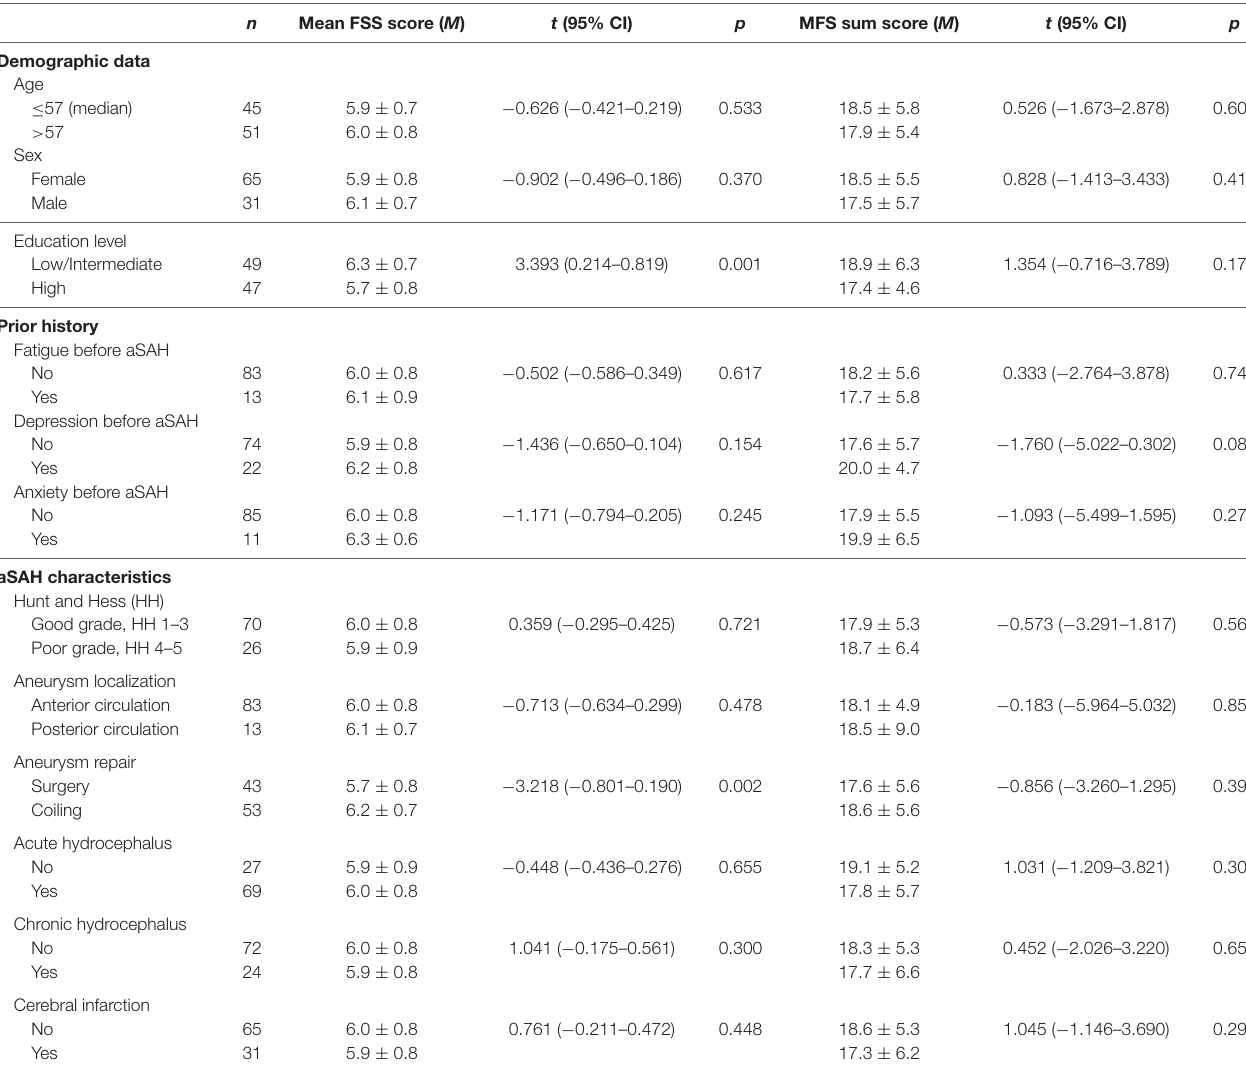
TABLE 4 | Relationship between mean Fatigue Severity Scale (FSS) scores, Mental Fatigue Scale (MFS) sum scores, demographics, prior history of fatigue and mood disorders, and hemorrhage